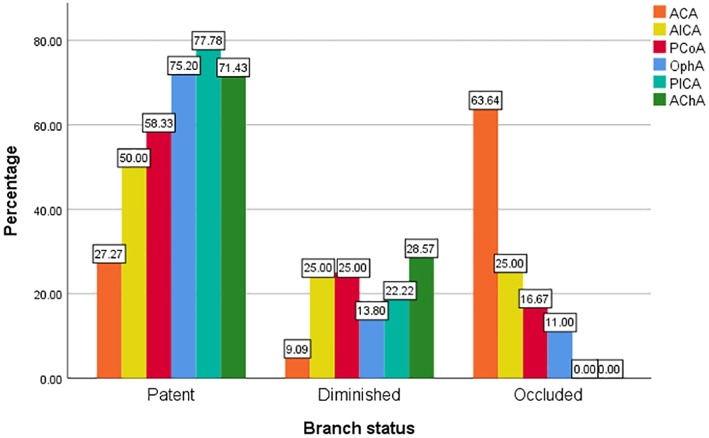
Status of the side branches involved by PED at follow-up.